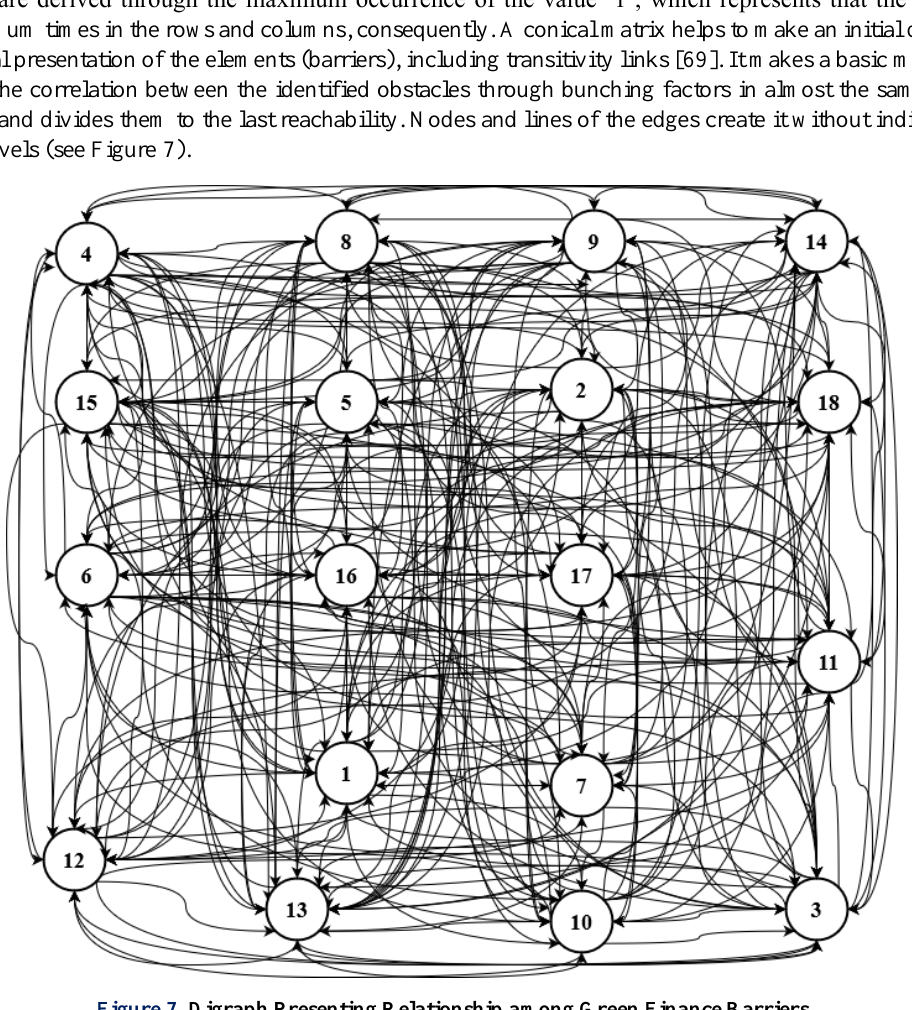
Figure 7. Digraph Presenting Relationship among Green Finance